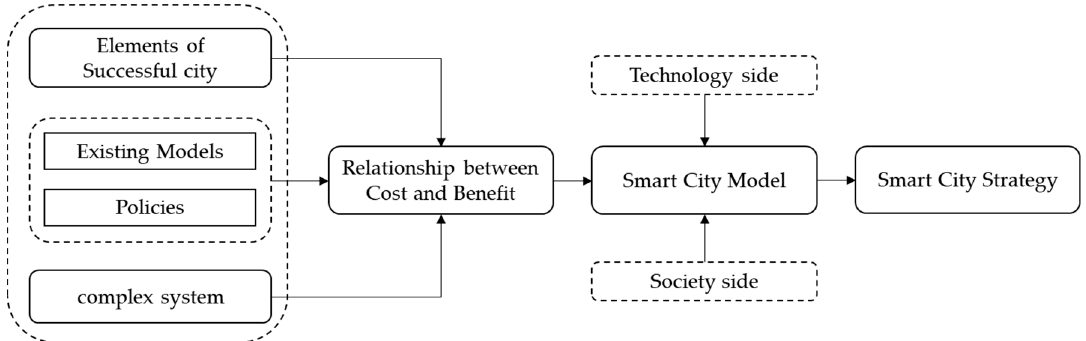
Figure 2. Model derivation process of the smart city.